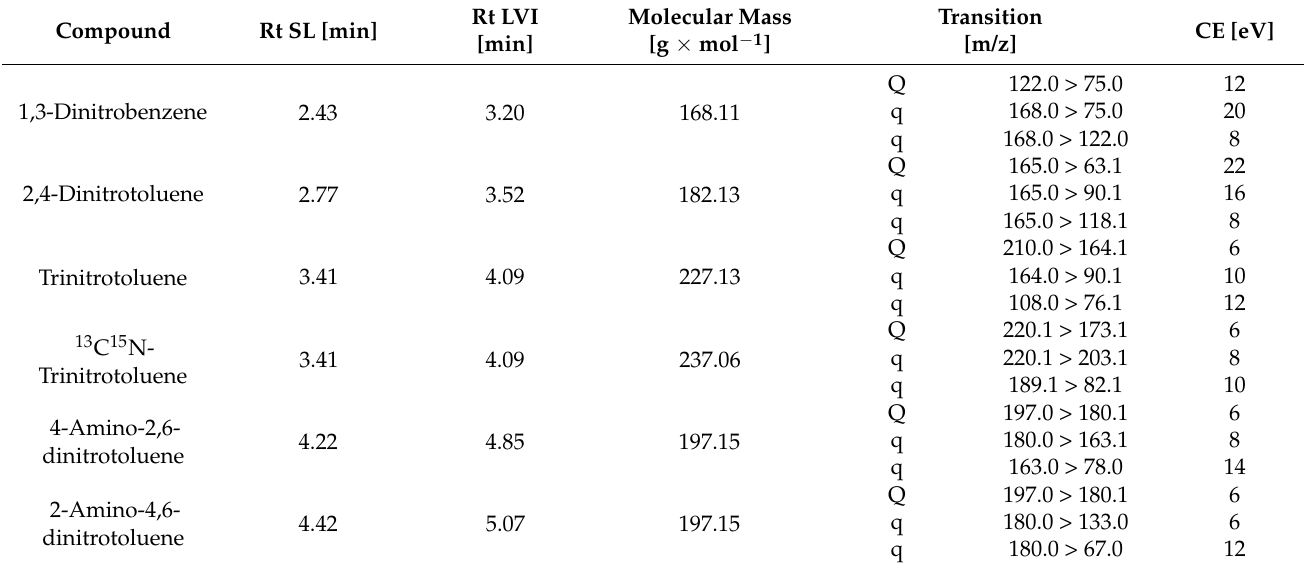
Table 2. Retention times for the splitless (Rt SL) and programmable temperature vaporization (PTV)-large volume injection (Rt LVI) methods; quantitative (Q) and qualitative (q) secondary reaction monitoring transitions (m/z) of explosives and internal standard 13 C 15 N-2,4,6-trinitrotoluene (TNT).